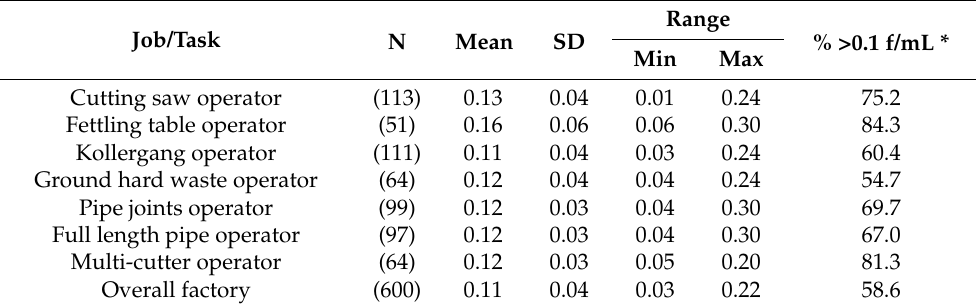
Table 3. Mean airborne personal chrysotile fibre concentrations (f/mL) for various operations/tasks in the Bulawayo chrysotile cement manufacturing